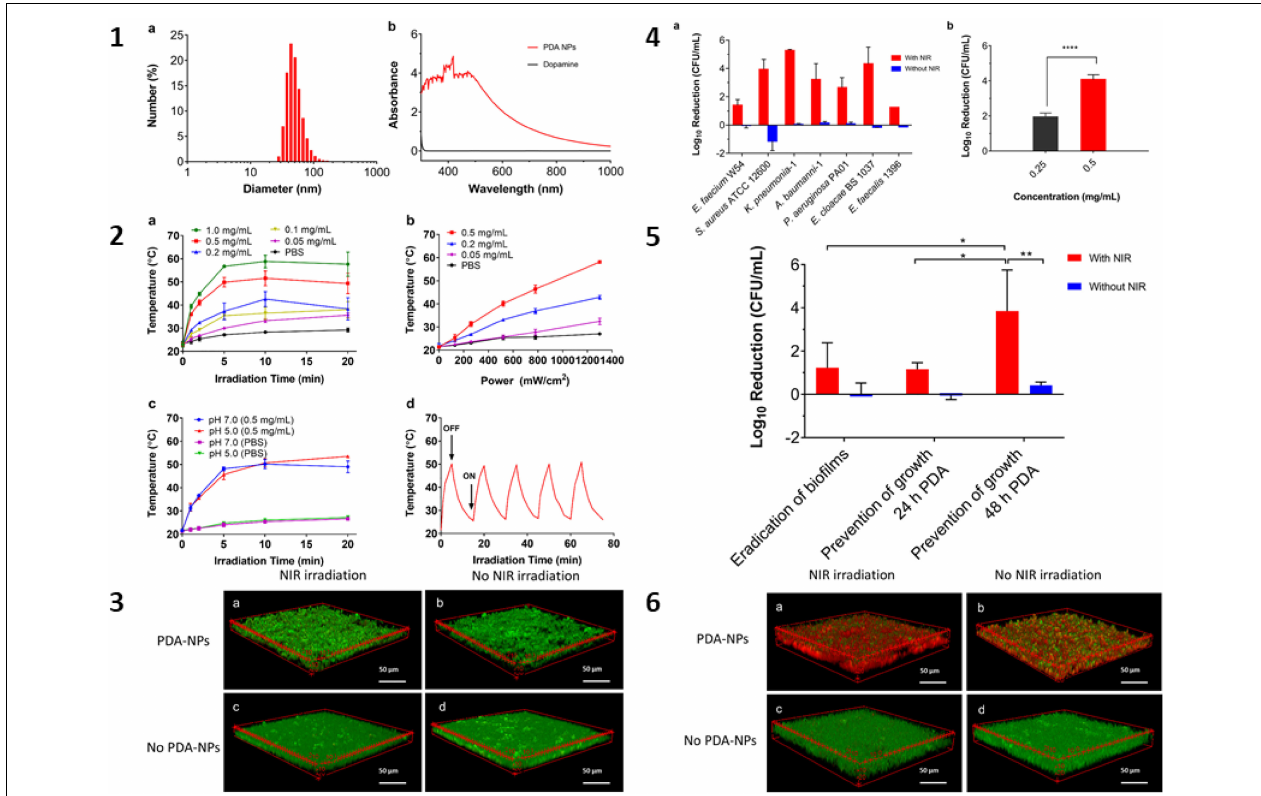
FIGURE 3 | Eradication of ESKAPE panel pathogens biofilms using photothermal polydopamine nanoparticles (PDA-NPs). (1) characterization of PDA-NPs, (2) photothermal properties of PDA-NPs at NIR radiation (880 nm); (3) CLSM image for photothermal killing of PDA-NPs against S. aureus biofilms (48 h old)